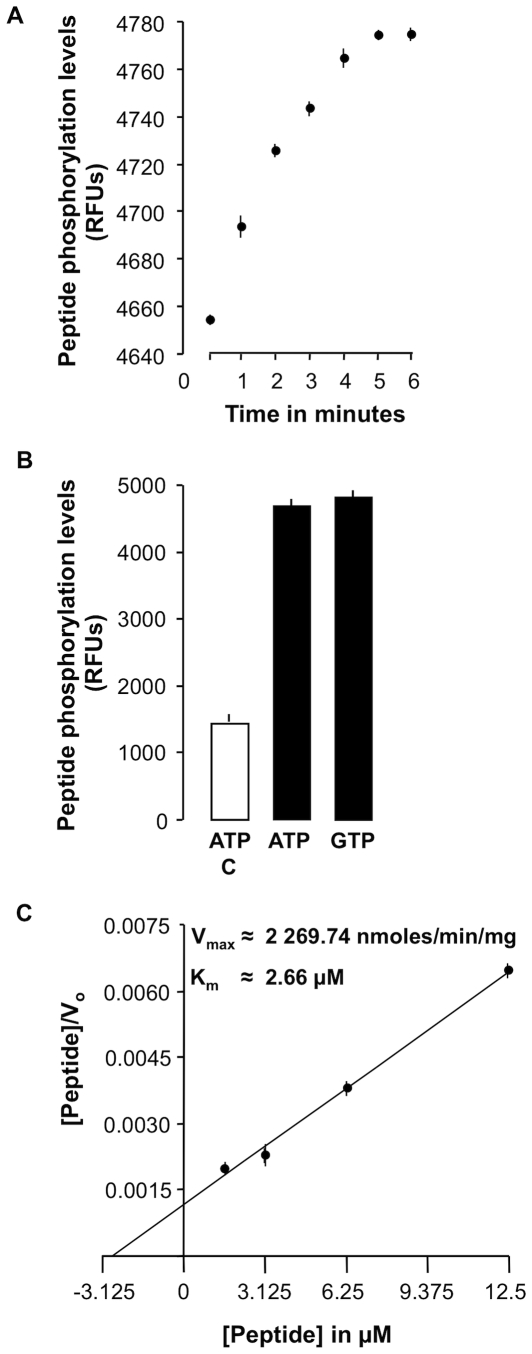
Determination of the kinase activity of the recombinant AtWAKL10.(A) The calibration curve obtained was produced in the presence 0.1 ng recombinant AtWAKL10431–700 in a reaction system containing 1 mM ATP, 0.2 mM DTT, and 25 µM Ser/Thr-peptide. Phosphorylation was quantified using the Omnia™Ser/Thr-Recombinant system at the indicated time points at 30°C (n = 3). (B) Kinase activity of AtWAKL10431–700 with either ATP or GTP as the substrate. The unfilled bar is a control which contained no recombinant protein (n = 3). (C) Hanes plot for the determination of the reaction kinetics of the recombinant AtWAKL10431–700 indicates the initial velocities for a number of Ser/Thr-peptide concentrations (1.563, 3.125, 6.25, and 12.5 µM) (n = 3). Estimated values for the kinetic constants (Km and Vmax) for the recombinant AtWAKL10 protein were derived from this plot. Km was determined as the negative value of the x-intercept (x = −Km, when y = 0) of the linear fit of the data, while Vmax was calculated from the y-intercept (y = Km/Vmax, when x = 0). Error bars represent the SEM.